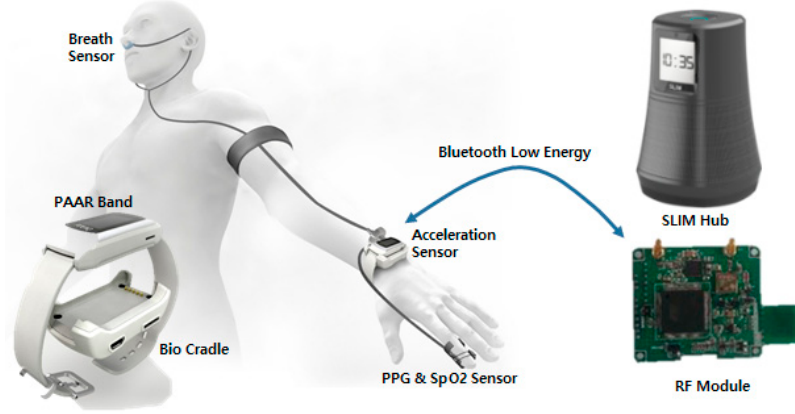
Figure 5. Multi-bio-signal measuring device and RF module of SLIM hub.